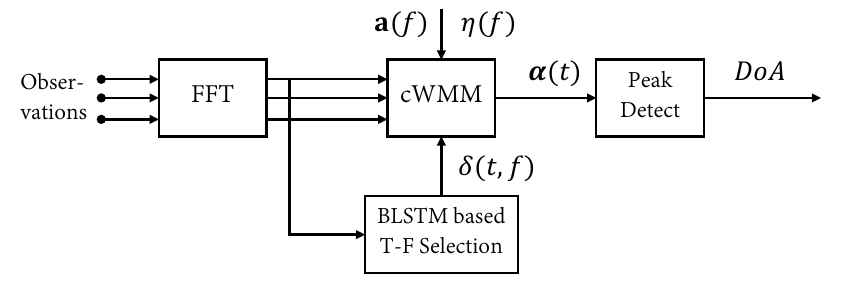
Figure 2. The processing pipeline of the proposed method.